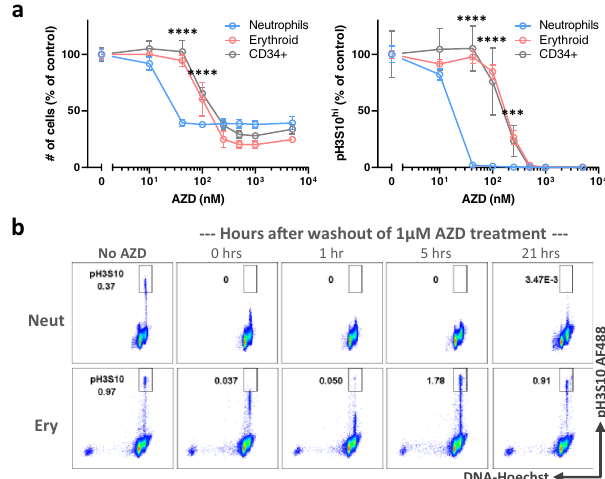
Fig. 3 | Increased sensitivity of neutrophils to AZD2811 is accompanied by impaired recovery after drug withdrawal. a Human CD34 + progenitor cells were cultured for 10 days and then treated for 48h with AZD2811 at various con- centrationsorDMSOvehicle.Cellswereharvestedandanalyzedby fl owcytometry to measure cellnumbers and the percentage of pH3S10 bright cells. Meanand SD are shown; n =6 for each concentration except n =3 at highest concentration (5 µ M), from 2 independent experiments. *** p =0.0001 (erythroid) and .0004 (CD34+), **** p <0.0001, 2-way ANOVA of erythroid and CD34 + cells compared against neu- trophils at AZD2811 various concentrations. b Human CD34 + progenitor cells were cultured for 12 days and then treated for 2h with 1 µ M AZD2811 or left untreated. AZD2811 was then washed out and cells were analyzed at the indicated timepoints afterwashoutbyintracellular fl owcytometryforpH3S10.Representative fl owplots are shown; n =4-6 except 21h timepoint has 2 data points, from 3 independent experiments. Source data are provided in the Source Data fi